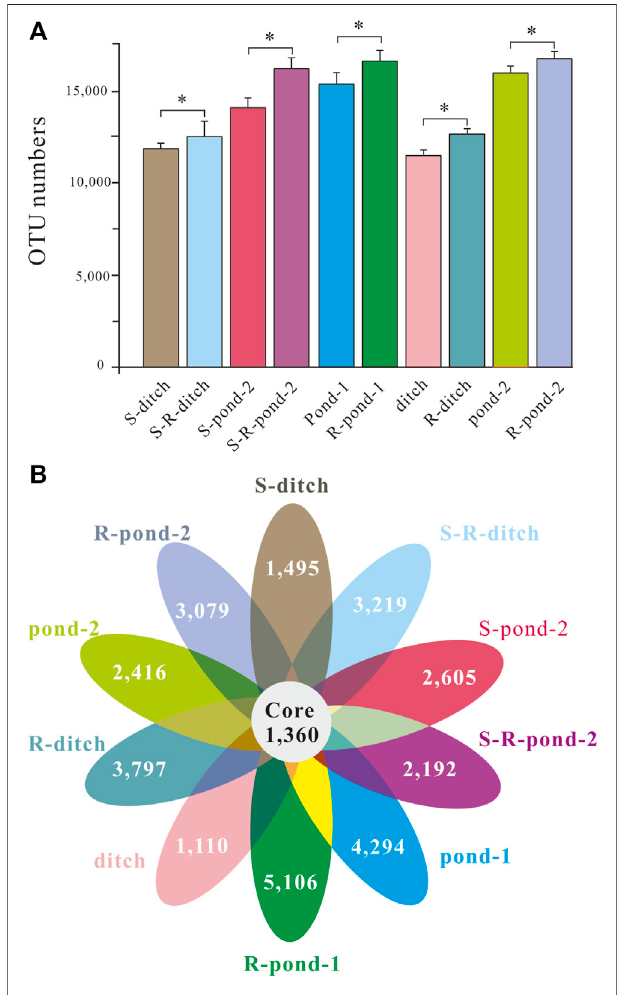
FIGURE 3 | OTU numbers and Venn diagram for two systems. (A) OTU numbers in the pond-1, R-pond-1, ditch, R-ditch, pond-2, R-pond-2 of the PDCS and S-ditch, S-R-ditch, S-pond-2, S-R-pond-2 of the control static group, respectively. Due to the death of plants in the pond-1 of the control static group died at the early stage, the data for the S-pond-1 and S- Rpond-1 were omitted. (B) Each circle represents a single microcosm of the PDCS systems. The numbers in the overlapping area of the circles represent the numbers of OTUs shared between the microcosms, while the numbers without overlaps represent the numbers of OTUs unique to these single